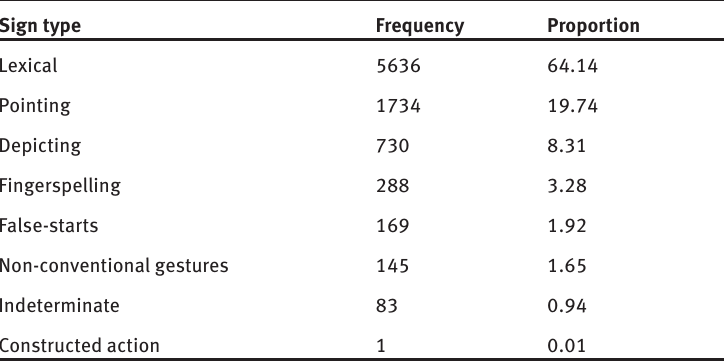
Table 3: Distribution of sign types across 179 scene